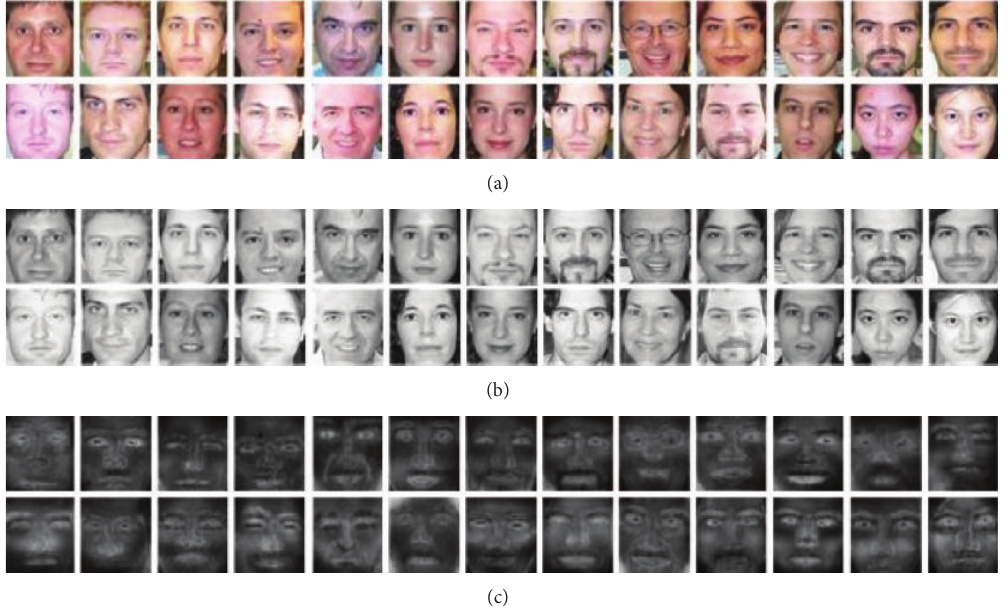
Figure 3: Sample images used in YaleB Database. As shown in the three 2 × 13 montages, (a) is the original images, (b) is the gray images, . Positive values are illustrated with white pixels. and (c) is the basis vectors learned by CNMF 𝛼 𝑘